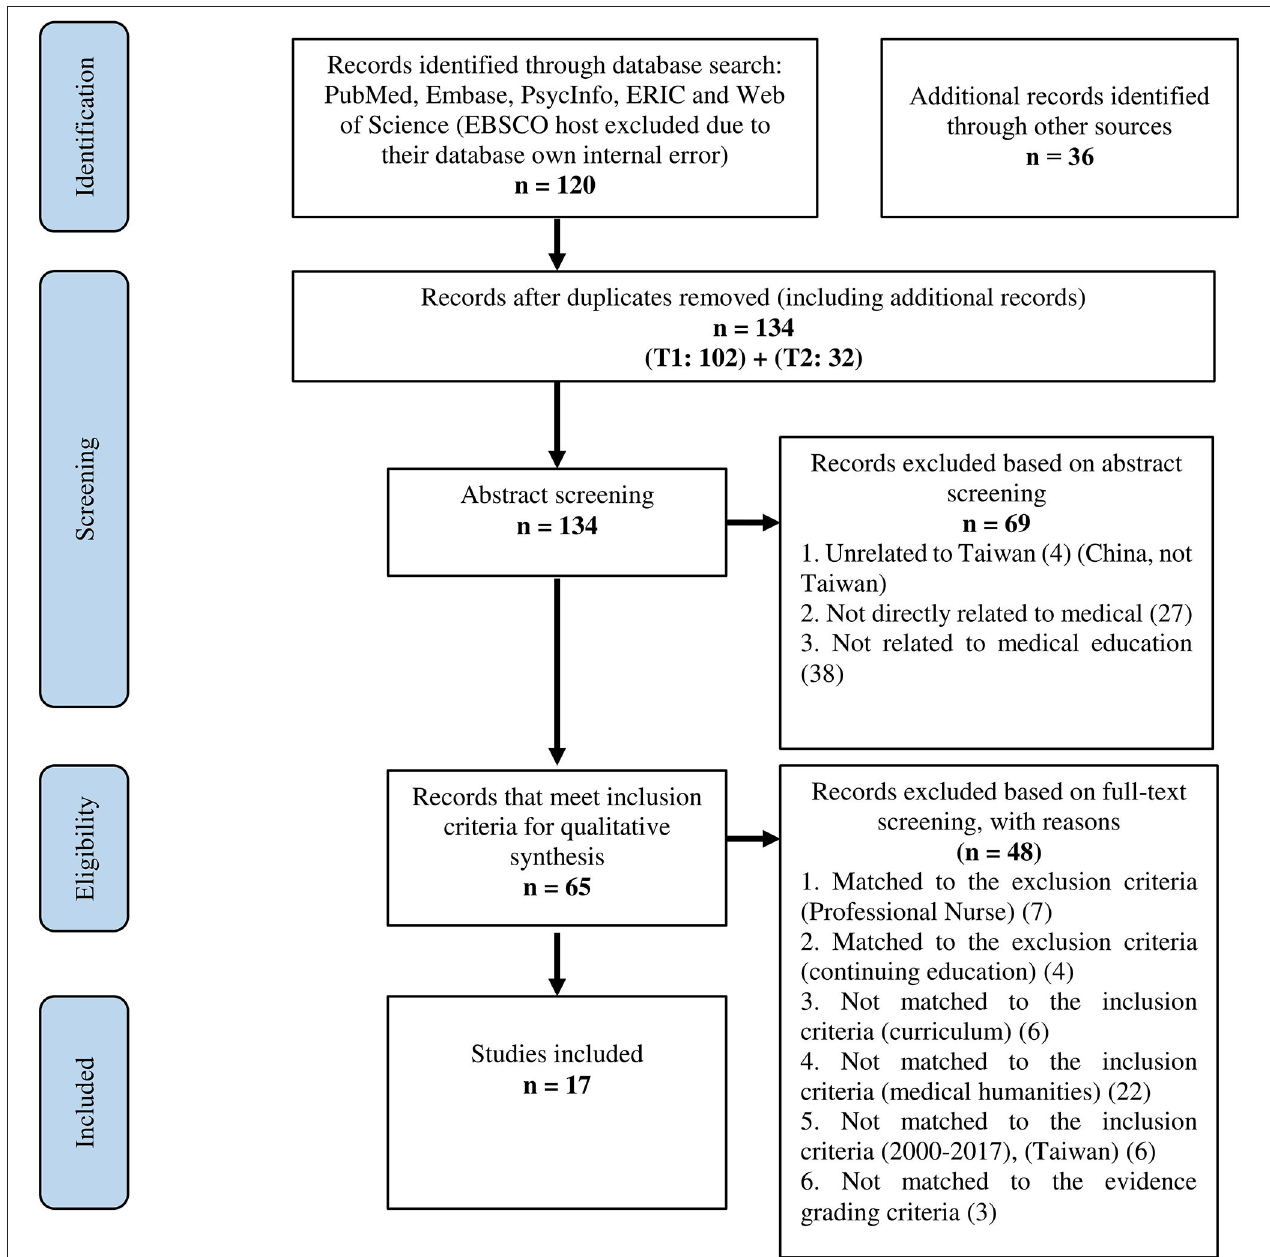
FIGURE 1 | PRISMA flow diagram of literature